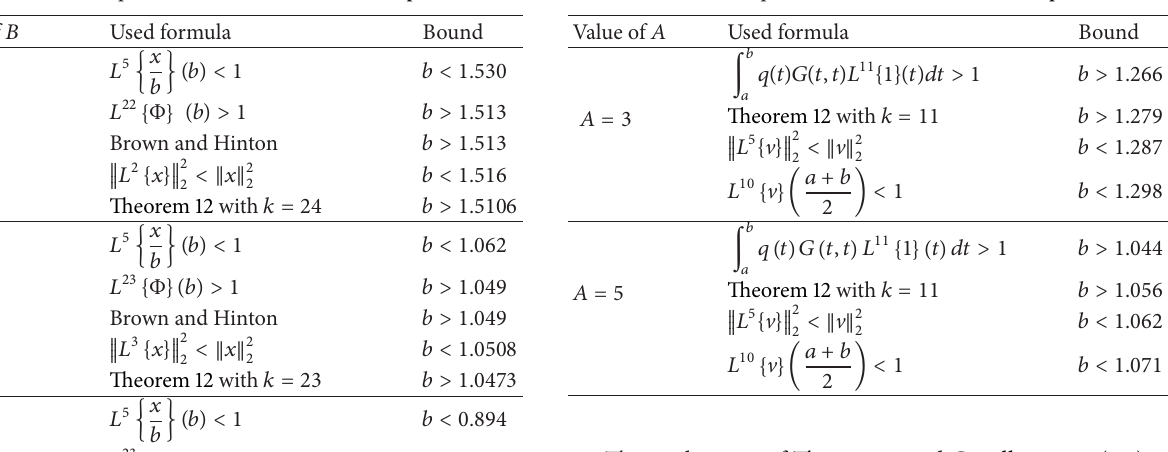
Table 2: Comparison of bounds for 𝑏 in Example 2.